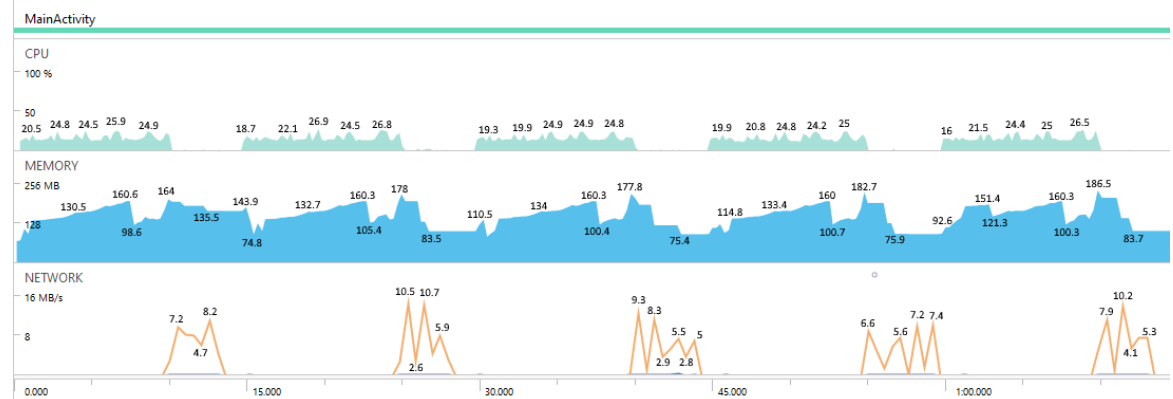
Figure 11. Multiple 15 MB file uploads.